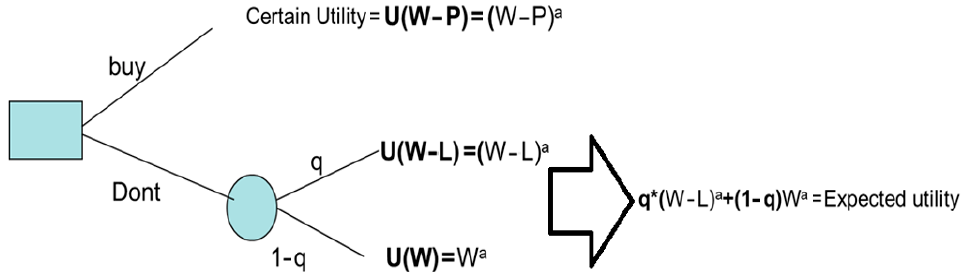
Figure 7. A utility maximizer policyholder’s decision to purchase an insurance policy.